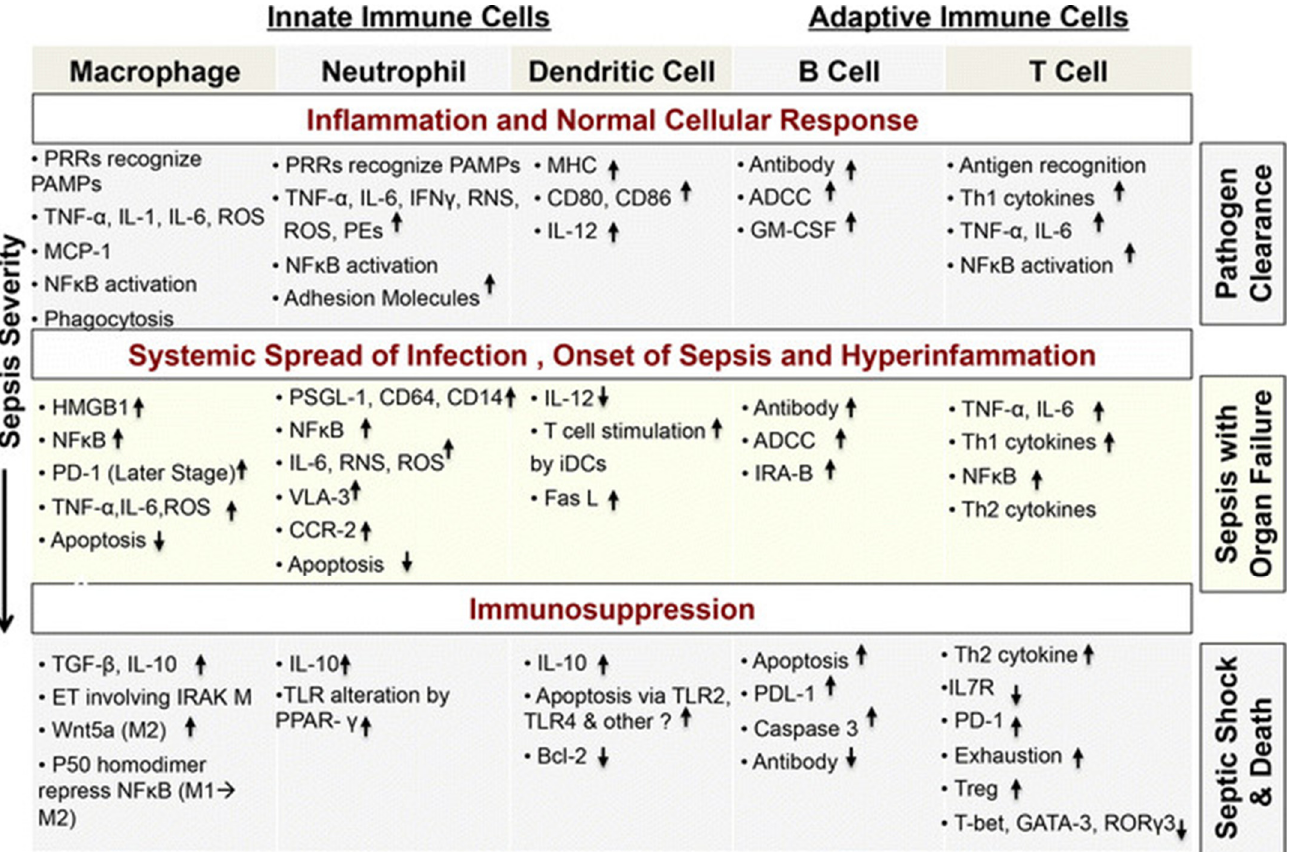
Figure 5. Overview of cellular changes occurring during sepsis. The first line shows the correct activation of the immune system during infection. If the innate and adaptive immune systems fail to contain the ongoing infection locally, the infection spreads systemically, triggering a hyperinflammatory innate and adaptive immune response. Further progression of infection and spread of the dysfunctional and altered cellular responses, including changed surface receptor expression, inappropriate inflammatory mediator secretion, and untimely apoptosis of immune cells, lead to the development of sepsis (middle panel). To regulate hyperinflammatory immune cell activities, the body goes through a loss of balance between inflammatory and anti-inflammatory response and a generalized immunosuppressive stage (bottom panel). As described in the figure, different phenotypic and molecular changes take place in immune cells as sepsis progresses. Thus, a host response that is designed to protect against pathogens causes tissue-damaging events, leading to multi-organ system failure and death. (Legend: ↑: increase; ↓ : decrease) In the literature, there are few articles describing changes in lymphocyte subpop- ulations during sepsis. In 32 septic patients with purulent meningitis [40], a decrease in the absolute number of total T lymphocytes at hospitalization and rapid recovery af- ter 7 days were observed. This lymphopenia involved CD4 + , CD8 + and NK cells and was more pronounced with a Gram-positive infection. Compared to healthy volunteers, the reduced number of circulating B lymphocytes correlated well with the incidence of nosocomial